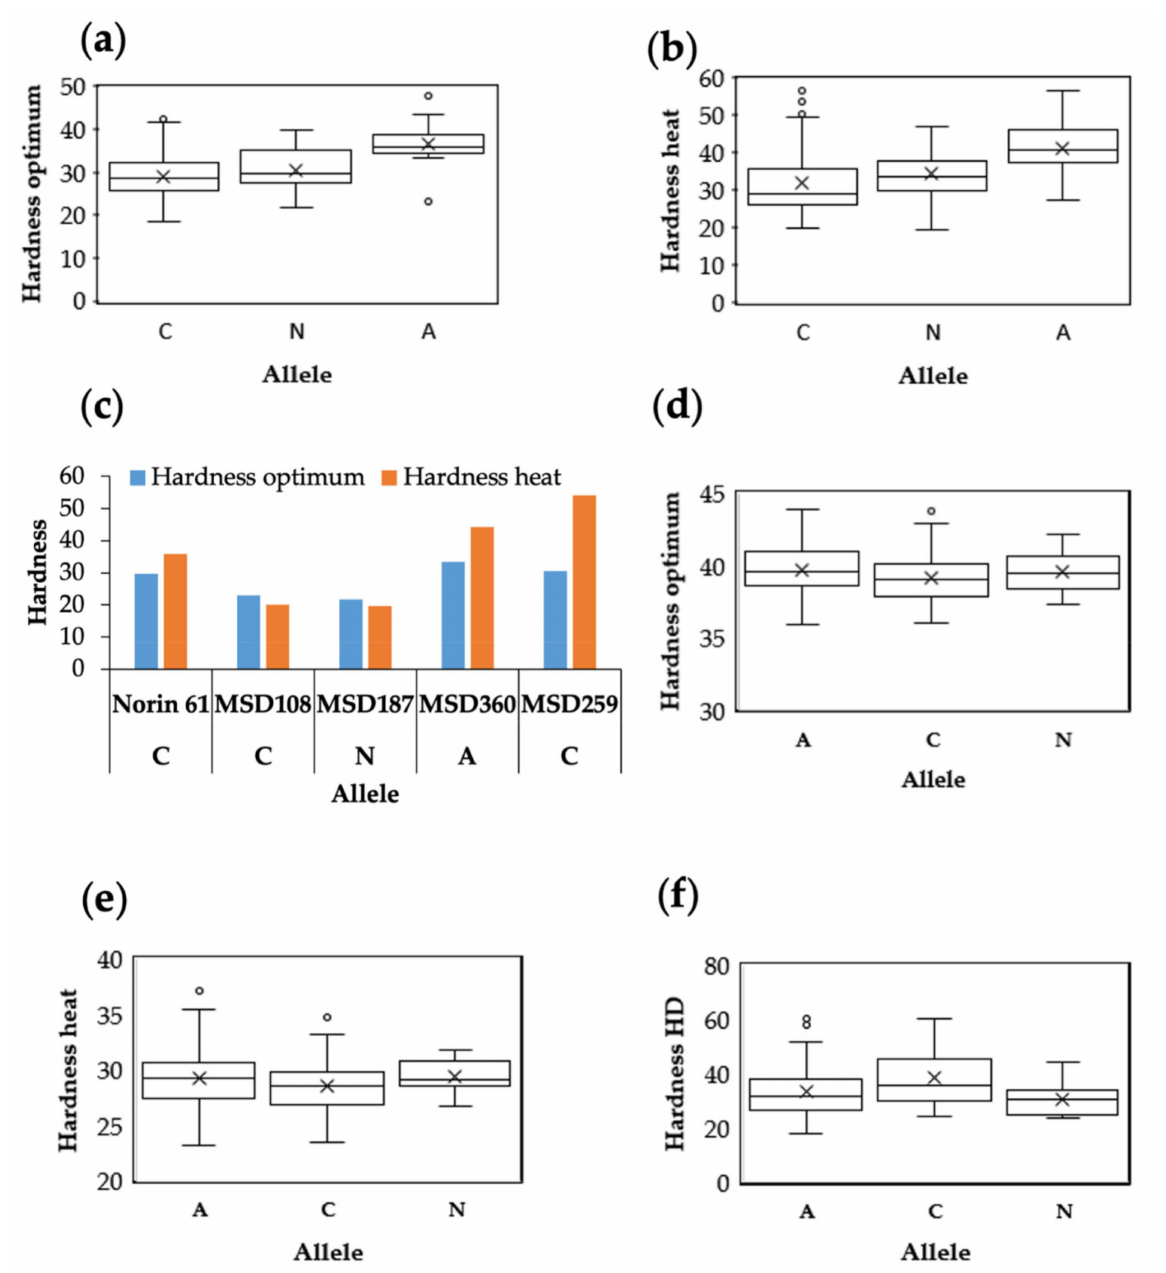
Figure 7. Boxplot for the marker 3532985; the marker that encodes for SUT gene. ( a ) Allele contributes for the marker under optimum environment, ( b ) Allele contributes for the marker under heat environment, ( c ) Allele contribution for MSD108, MSD187; the tolerant lines, and MSD162, MSD259; the sensitive lines, and ‘Norin 61’ their parent, ( d – f ) Boxplot for the allele for marker 3,947,128 that encode for celiac disease under optimum, heat and